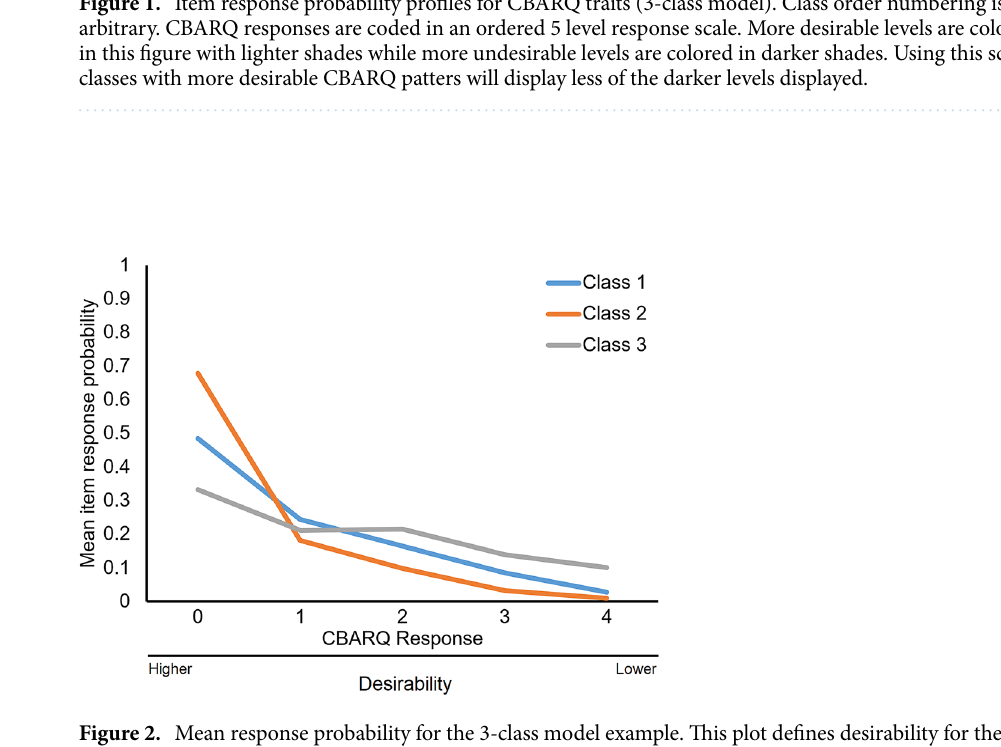
Figure 2. Mean response probability for the 3-class model example. This plot defines desirability for the class. Having the class with the highest proportion of the desired scores being designated as the most